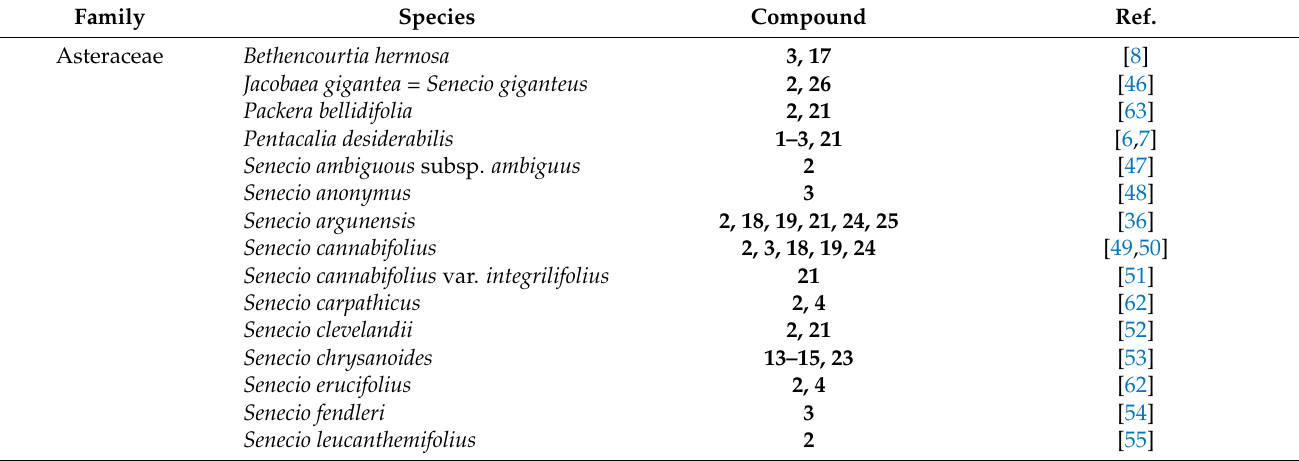
Figure 3. Naturally occurring jacaranone derivatives (dimers) *. * Stereochemistry of each compound is given as it was published. Table 2. List of plant families and species containing jacaranones.